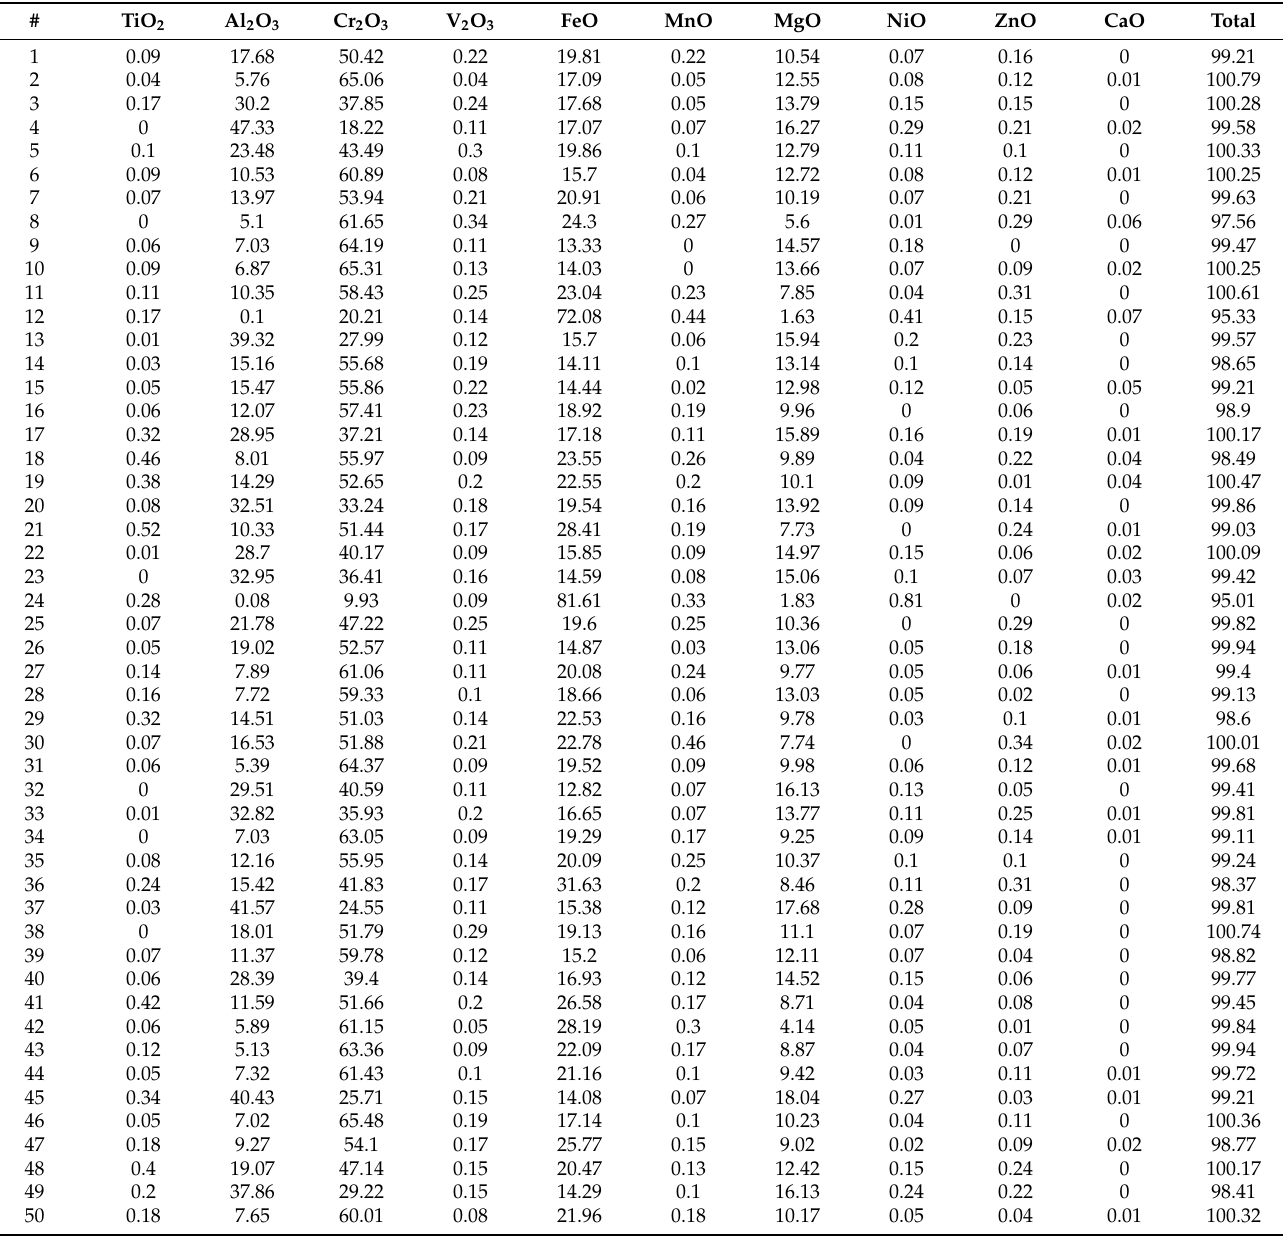
Table 2. Selective microprobe analyses of chromspinel from the Sabantuy paleoplacer